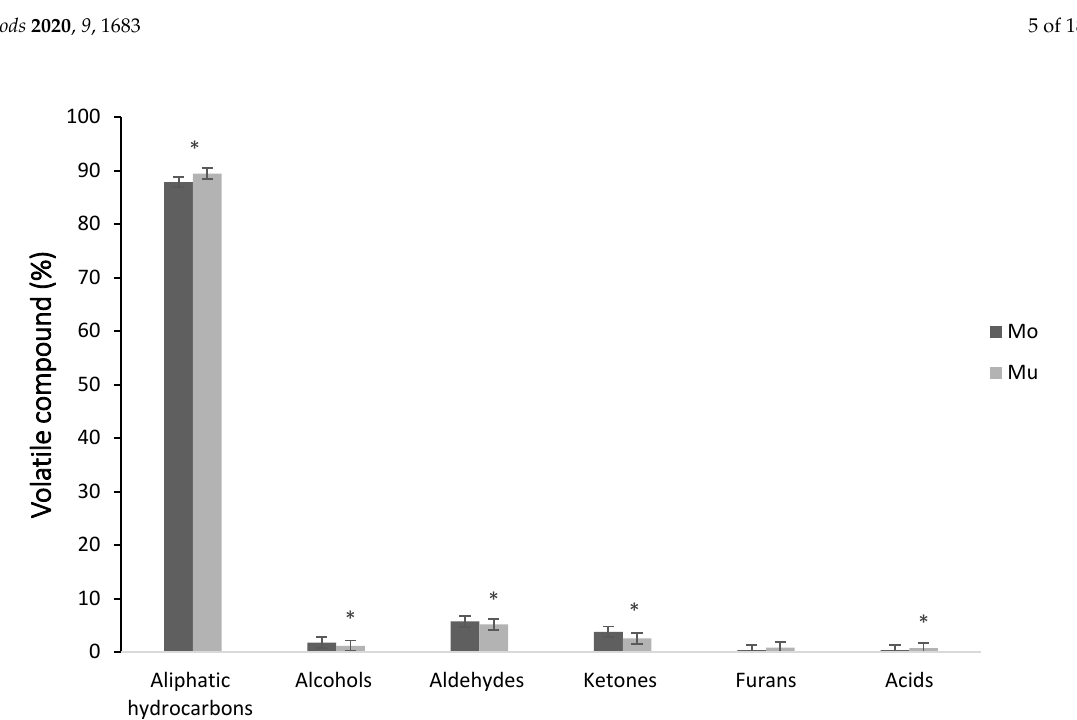
Table 1. Volatile compounds from monolayered (Mo) and multilayered (Mu) fish oil microcapsules. Values are expressed as peak area × 10 6 .